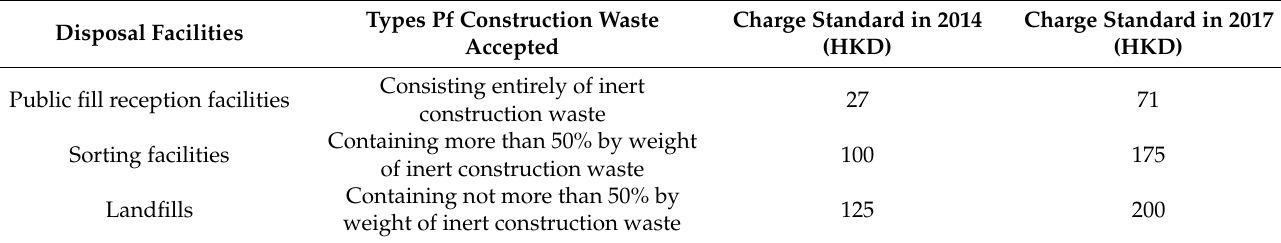
Table 1. Comparison of charging standards for construction waste